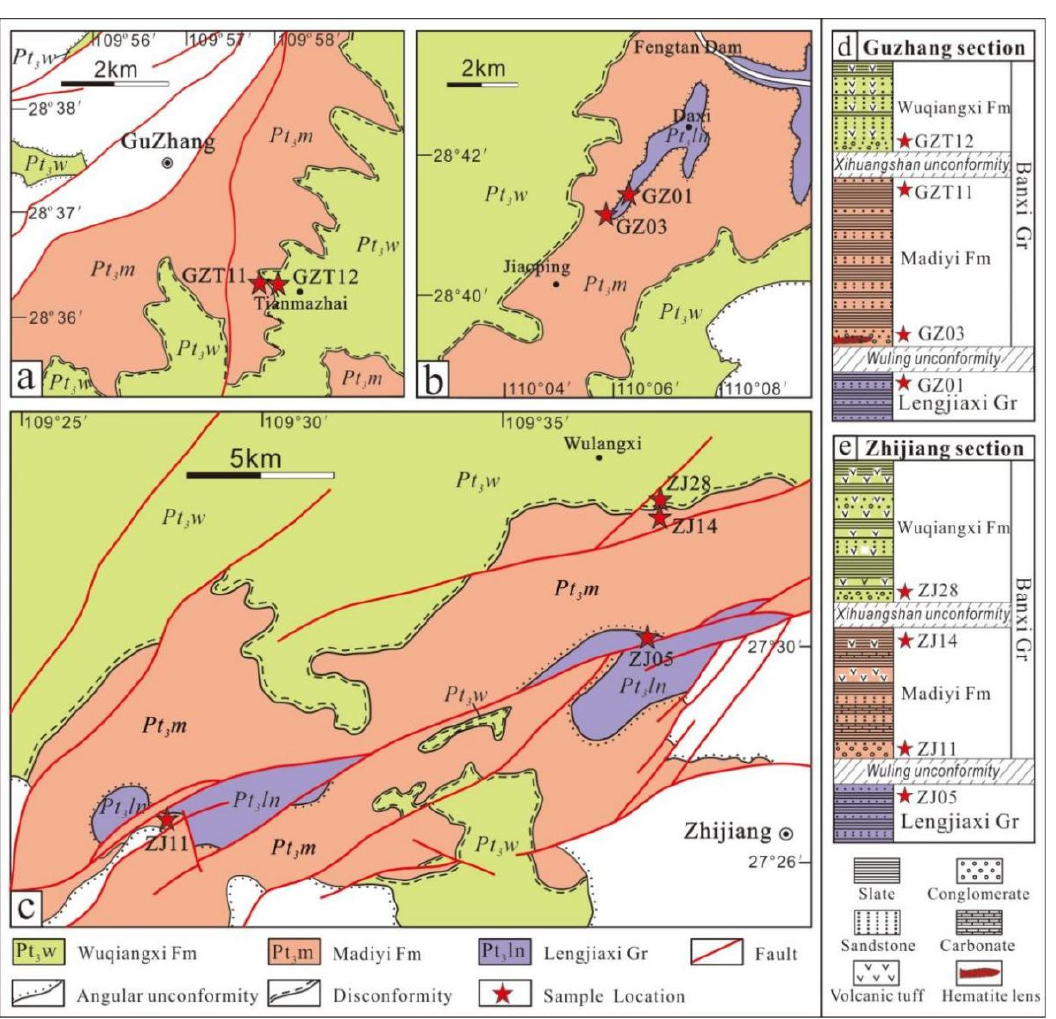
Figure 2. ( a,b ) Geological map of the sample locations in Guzhang area; ( c ) geological map of the sample locations in Zhijiang area; ( d ) stratigraphic section in Guzhang area and ( e ) Zhijiang area. (revised after [48,57]). Abbreviations: Gr—Group; Fm—Formation.